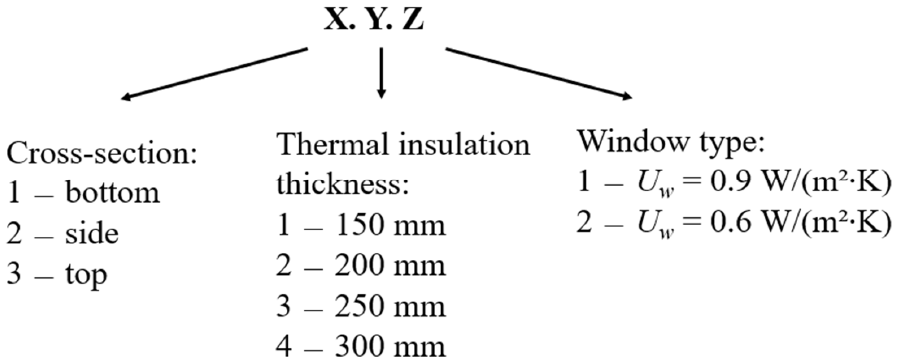
Figure 9. Numbering system for calculation variants.